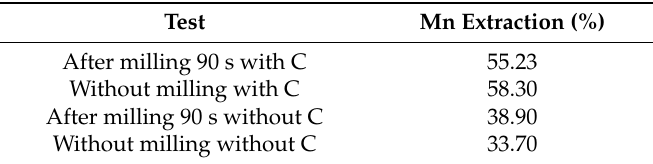
Table 7. Test carried out at 225 ◦ C for 45 min.